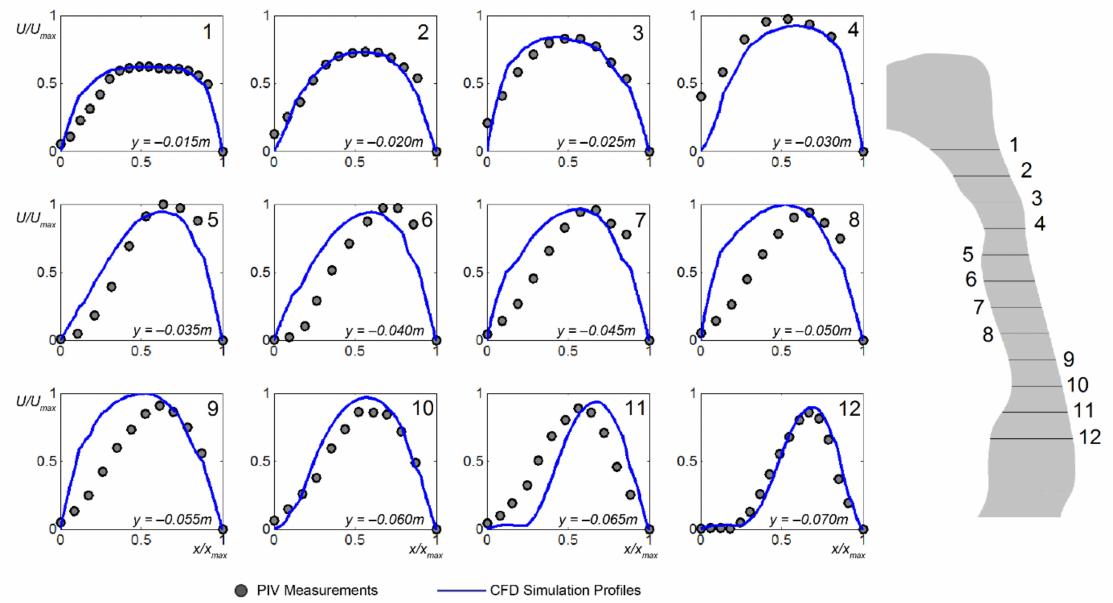
Figure 6. Horizontal normalised velocity profiles at di ff erent heights ( y -axis in Figure 5a) in mid-sagittal plane z = 0 mm). The velocity magnitudes, U are normalised by its global maximum value, U max , and the airway lumen distance x from the anterior wall to the posterior wall is normalised by x max